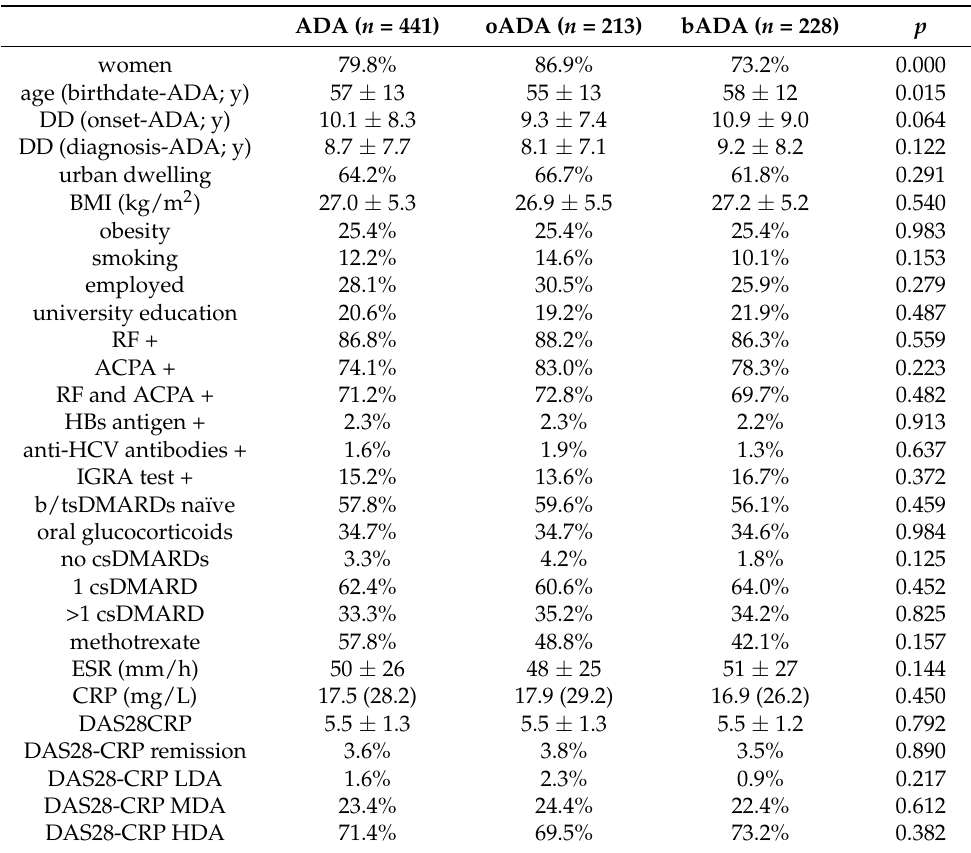
Table 1. Baseline demographic and RA